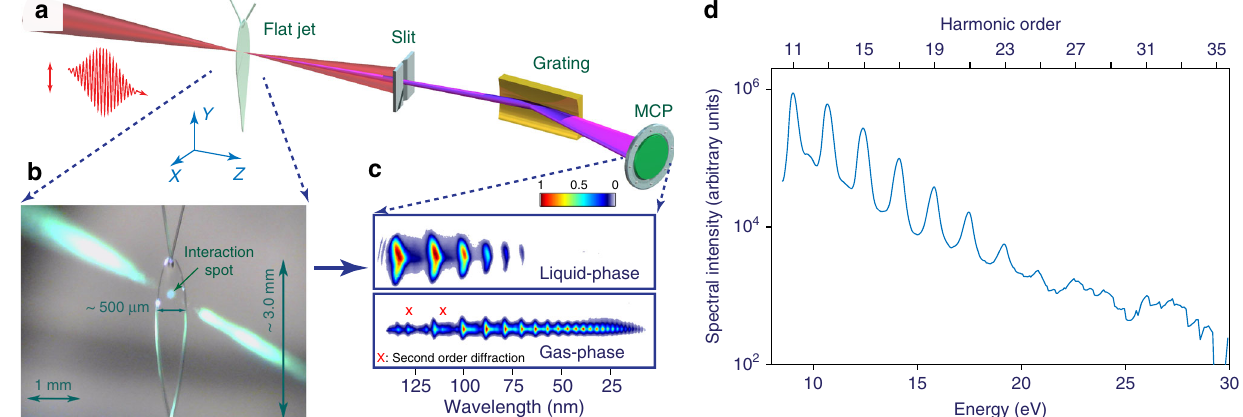
Fig. 1 Extreme – ultraviolet high – order harmonic generation from liquid samples. a Experimental apparatus consisting of a liquid fl at microjet and a fl at – fi eld spectrometer with a multi-channel plate (MCP). b Photograph of the laser – liquid interaction. The scattering of third harmonic (green) can be clearly observed. c Typical spatio – spectrally resolved far – fi eld images of EUV emission from the liquid and gas – phase ethanol. The two spectra are individually normalized to the maximum peak intensities, as displayed in the color bar. d HHG spectrum recorded from interaction of laser pulses (30 fs, 1.5 μ m, 1.2 mJ at 1 kHz, effective peak electric fi eld strength of ≈ 1.5 V/Å inside the medium) with liquid